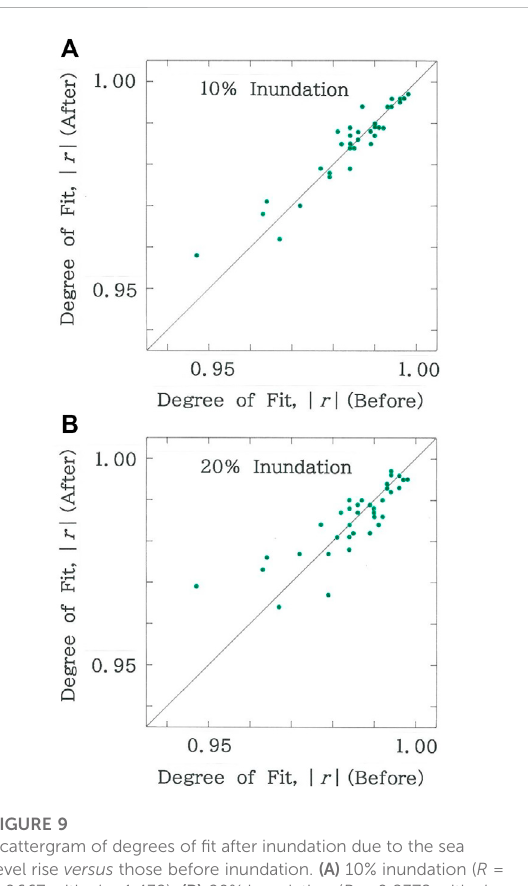
FIGURE 9 Scattergram of degrees of fi t after inundation due to the sea level rise versus those before inundation. (A) 10% inundation ( R = 0.9667 with d = 1.432). (B) 20% inundation ( R = 0.8378 with d =